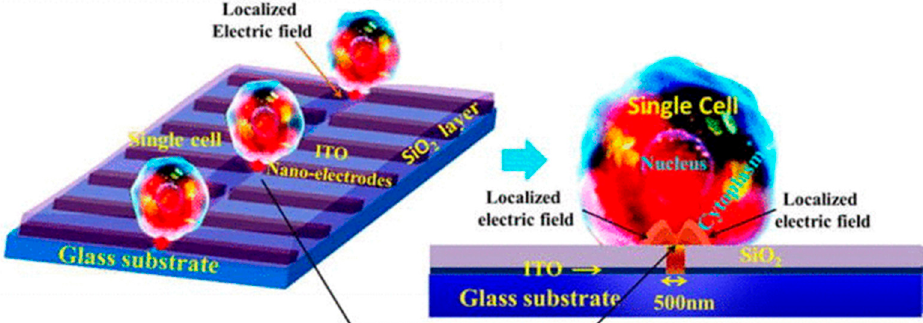
Figure 22. Schematic representation of localized single cell nano electroporation (LSCNEP) chip. Reproduced from [162] with the permission of AIP Publishing.